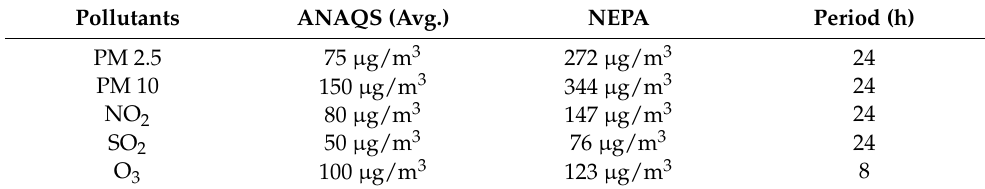
Table 10. Air pollutants